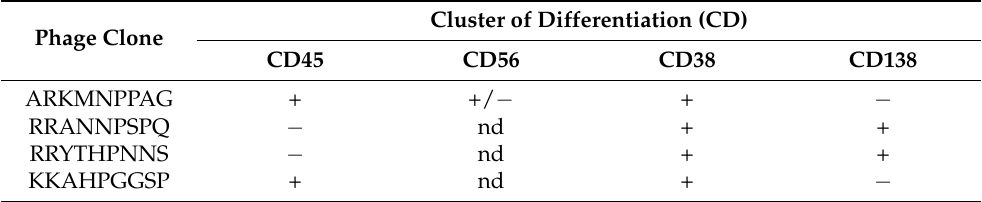
Table 2. Phage array for MM immunophenotype